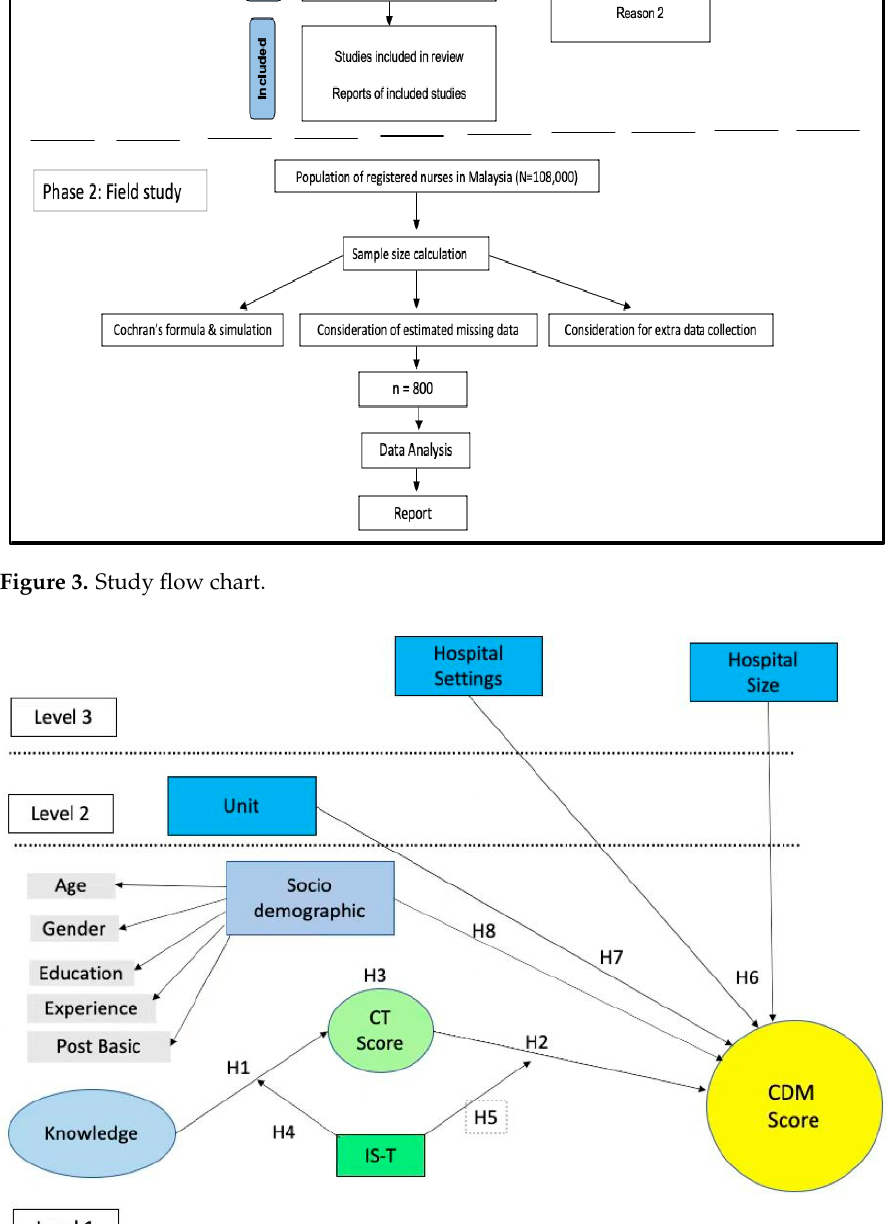
Figure 4. Conceptual framework of multilevel modeling of critical thinking and clinical decision- making skills.